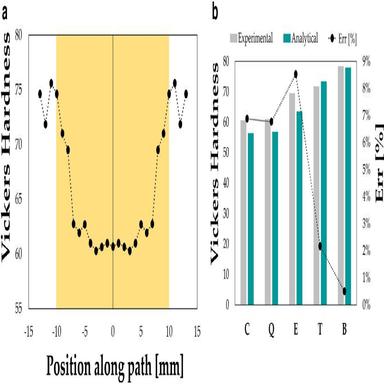
Local laser heating: a) hardness measurements along the longitudinal path; b) comparison with the predicted values.